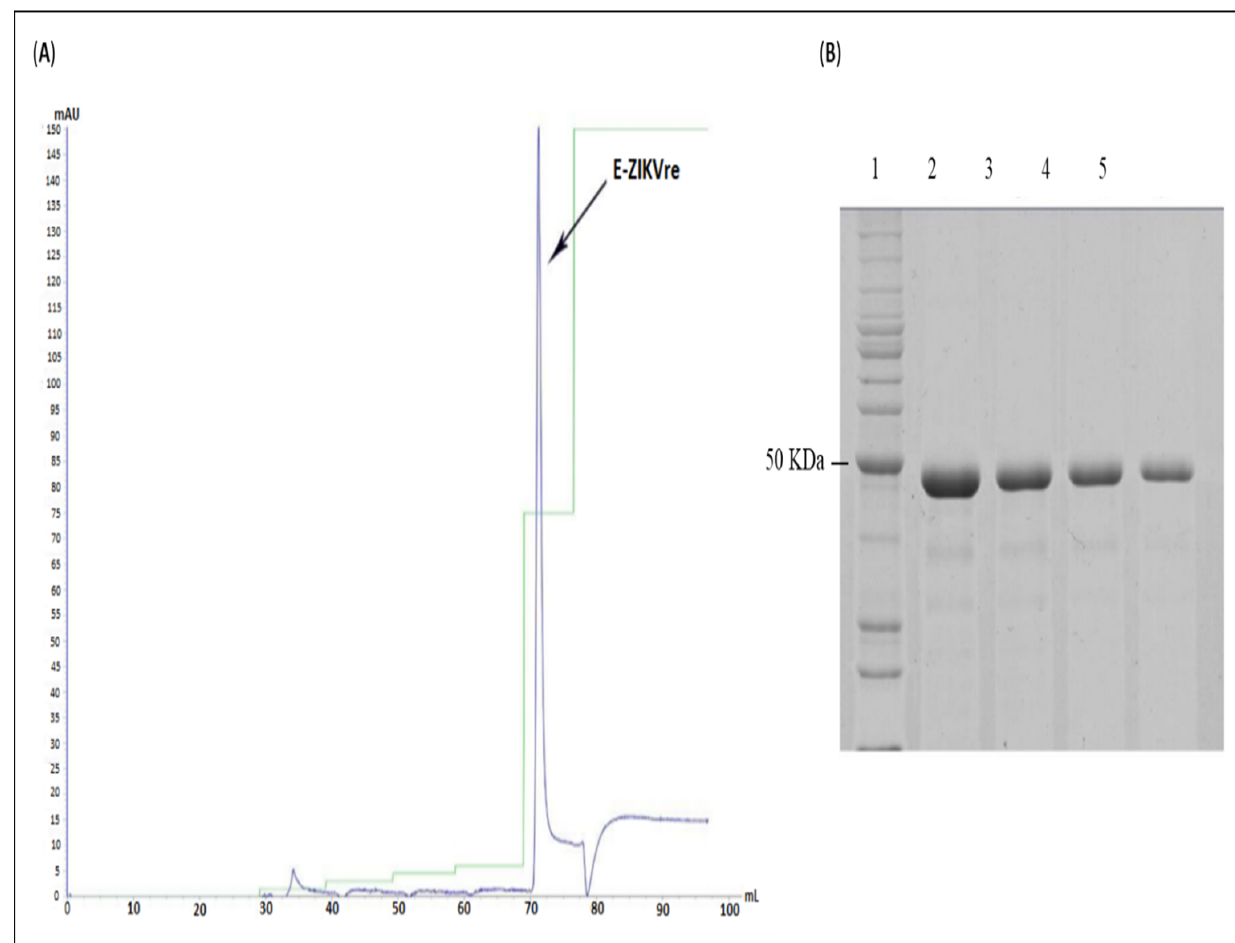
Figure 5. Analysis of the E-ZIKVre protein purification step. ( A ) Chromatogram of purification of protein by IMAC on Ni 2+ column. On the vertical axis are the absorbance values in mAU (l = 280 nm) and on the horizontal axis are the volumes in milliliters. The blue peak represents the E-ZIKVre protein. Elution in 20 mM Tris-HCl + 1 mM EDTA + 0.5% triton x-100 + 4M urea (pH 8.0). ( B ) SDS-PAGE of E-ZIKVre protein purification product by IMAC. Line 1—benchmark; lines 2–5—purified fractions of E-ZIKVre protein.